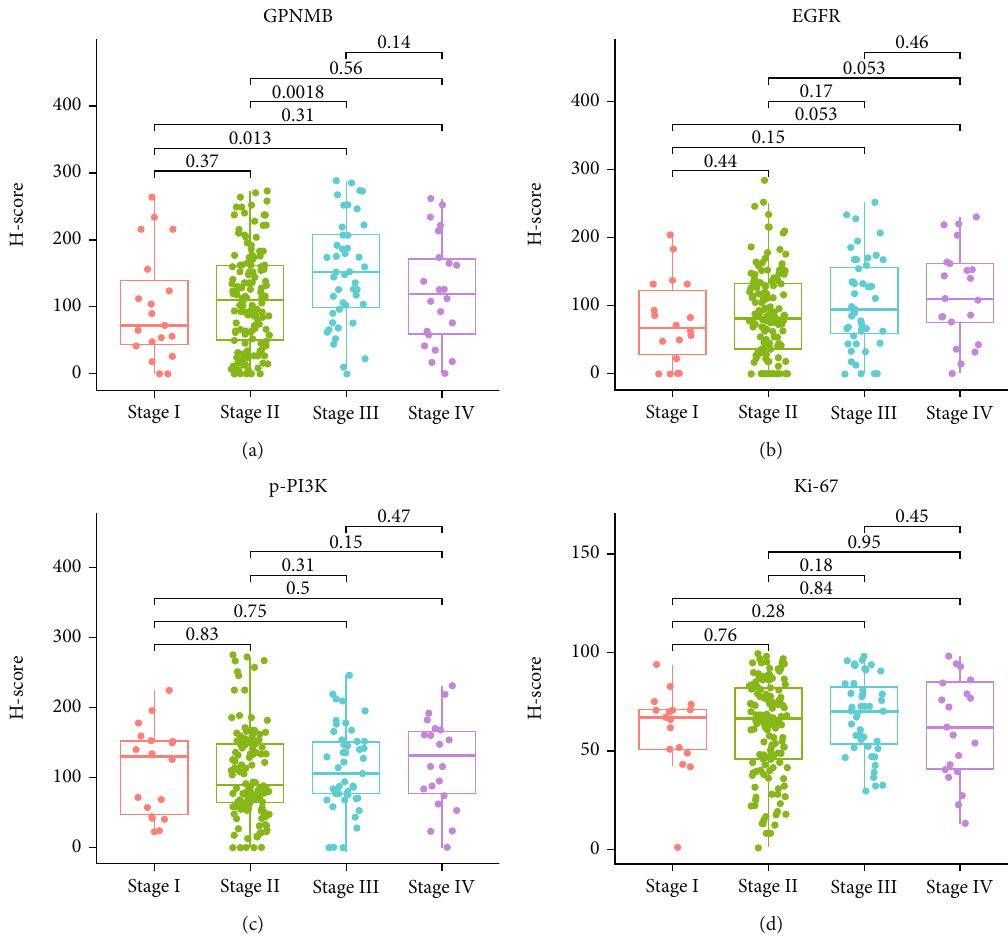
Figure 4: Expression of four proteins at di ff erent AJCC stages. The Kruskal-Wallis rank-sum test was used to analyze the expression di ff erences of (a) GPNMB, (b) EGFR, (c) p-PI3K, and (d) Ki-67 in di ff erent stages. The box plot shows the median value (quartile) of the two